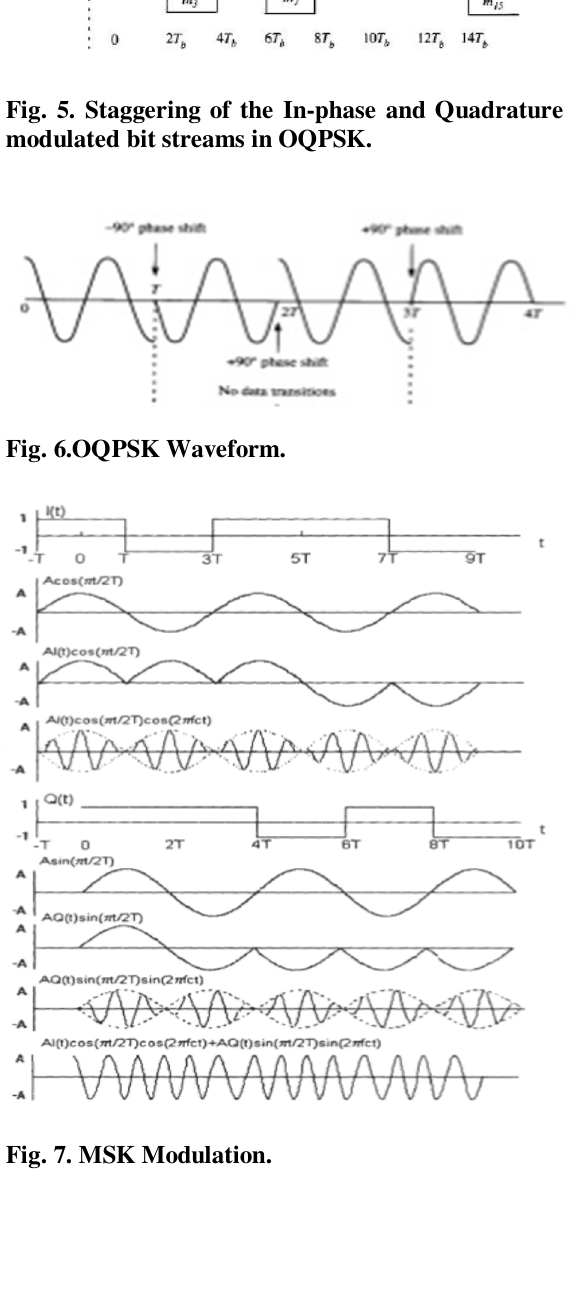
Fig. 3. Types of Digital Modulation.